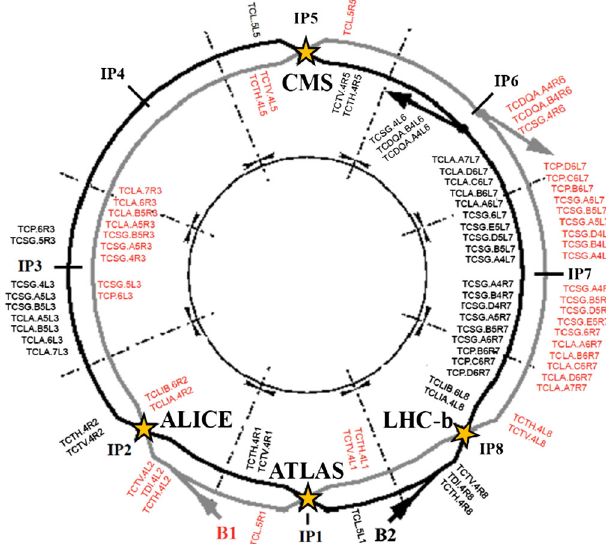
FIG. 1. Sketch of the collimator layout in the LHC IRs during Run 1. Collimators are installed on both beam lines, all around the LHC ring. They are located mainly in IR3 and IR7, where they ensure momentum and betatron cleaning of the particles, respectively. Collimators also protect the four experiments (ATLAS [7], ALICE [8], CMS [9], and LHCb [10]), the beam dump (IR6), and the transfer line regions. Collimators for Beam 1 (red) and Beam 2 (black) are distinguished (adapted from [6]).